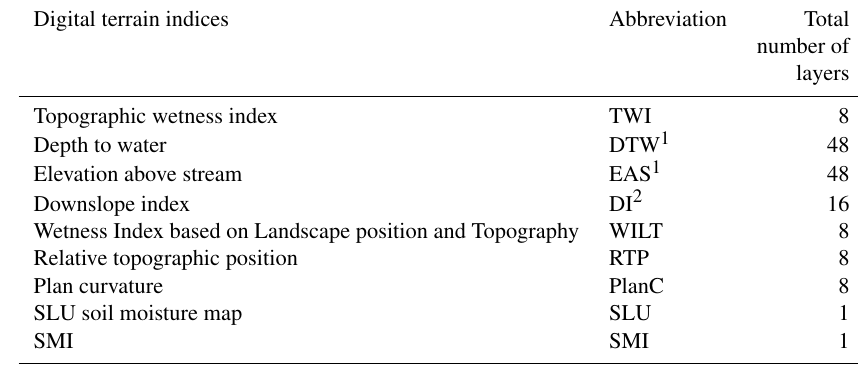
Table 1. All indices calculated in this study. Calculations were made for resolutions of 0.5, 1, 2, 4, 8, 16, 32 and 64m. 1 Calculations were also done for stream initiation thresholds of 1, 2, 4, 8, 16 and 32ha. 2 Calculated with vertical distances of 2 and 4m. All GIS calculations were carried out using Whitebox Tools (Lindsay, 2016b), except for SLU soil moisture map and SMI, which were downloaded from other